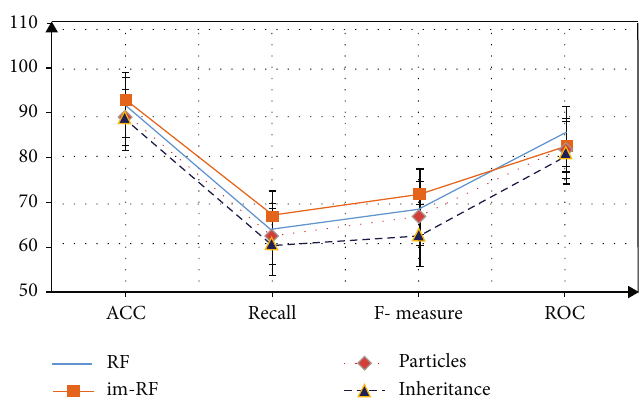
Figure 3: E ff ect of feature importance on algorithm performance.